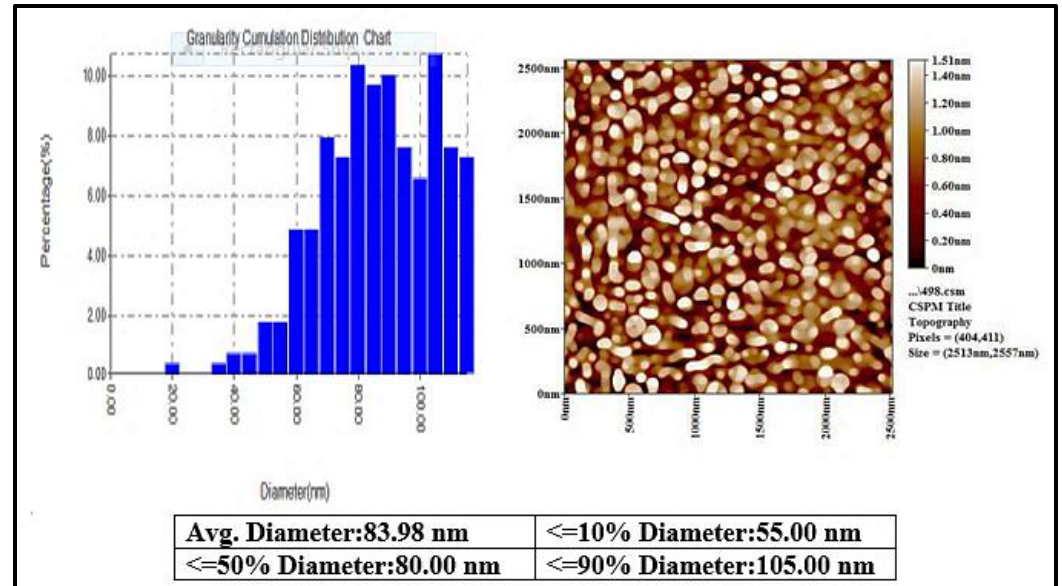
Fig. 2: Particle size and distribution of hybrid nanoparticles (70% ZrO through Atomic Force Microscope